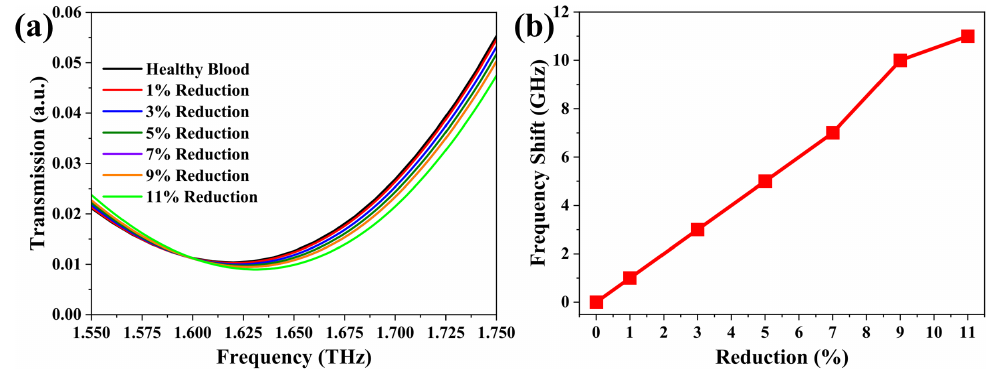
Figure 4. ( a ) Transmission spectra of BTR structure with hydrogenated BP monolayer and ( b ) the corresponding resonance-frequency shift at different permittivity